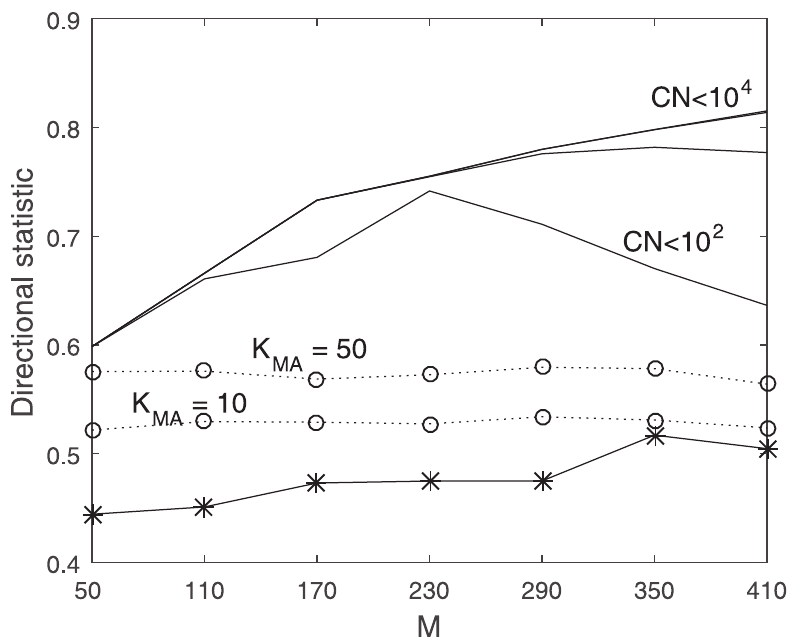
, 10 2 associated with yy